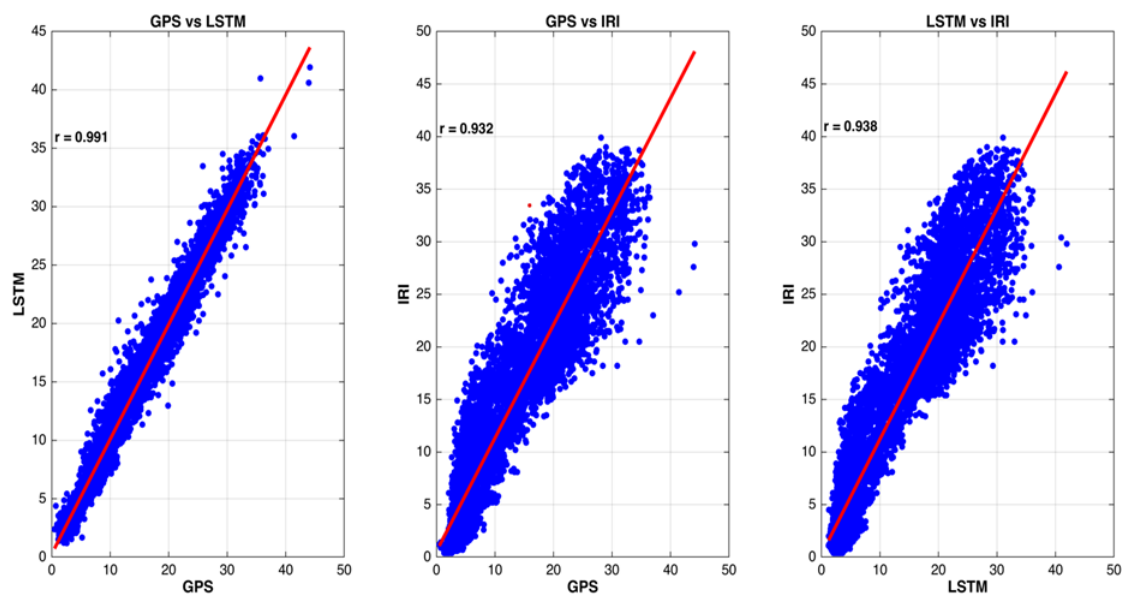
Figure 8. Scatter plots for hourly GPS TEC and corresponding modeled TEC values using LSTM and IRI models.